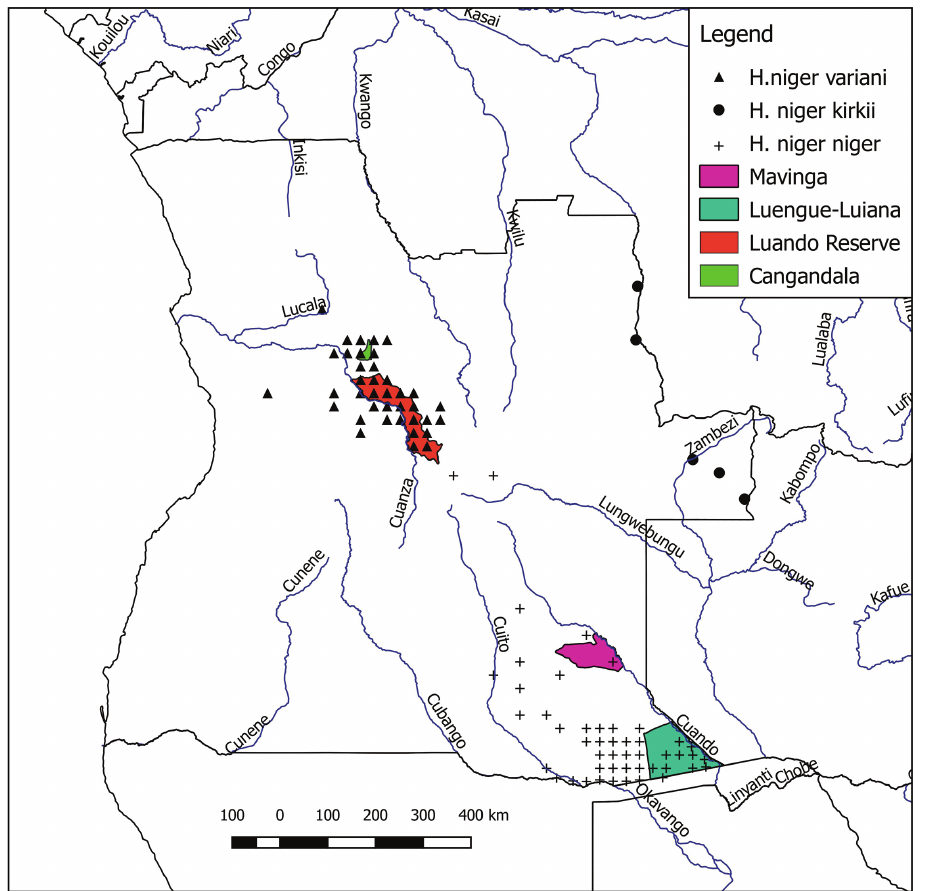
Figure 3. Historical distribution of the nominate sable subspecies ( Hippotragus niger niger ), Kirk’s sable ( H. niger kirkii ) and the giant sable ( H. niger variani ) in Angola based on records of the Instituto de Investigação Científica Tropical (IICT) in Portugal (obtained via GBIF search). Protected areas where H. n. niger and H. n. variani currently known to occur are indicated in the legend. The subspecies H. n. kirkii from eastern Angola has not been recorded during the past 40